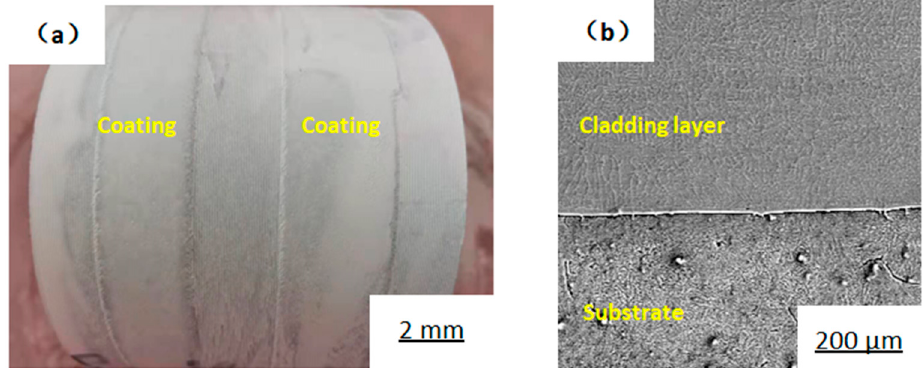
Figure 4. Flaw detection of cladding layer and its cross-section metallographic microscope obser- vation. ( a ) Flaw detection; ( b ) microscopic observation of cladding layer.